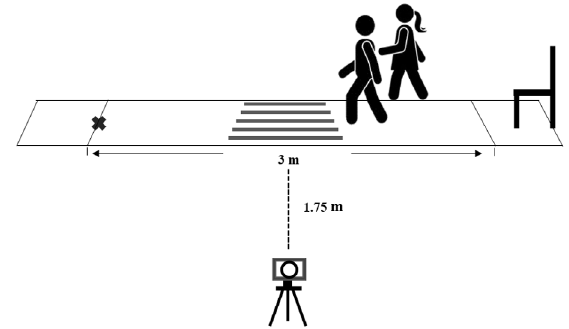
Figure 2. Data collection